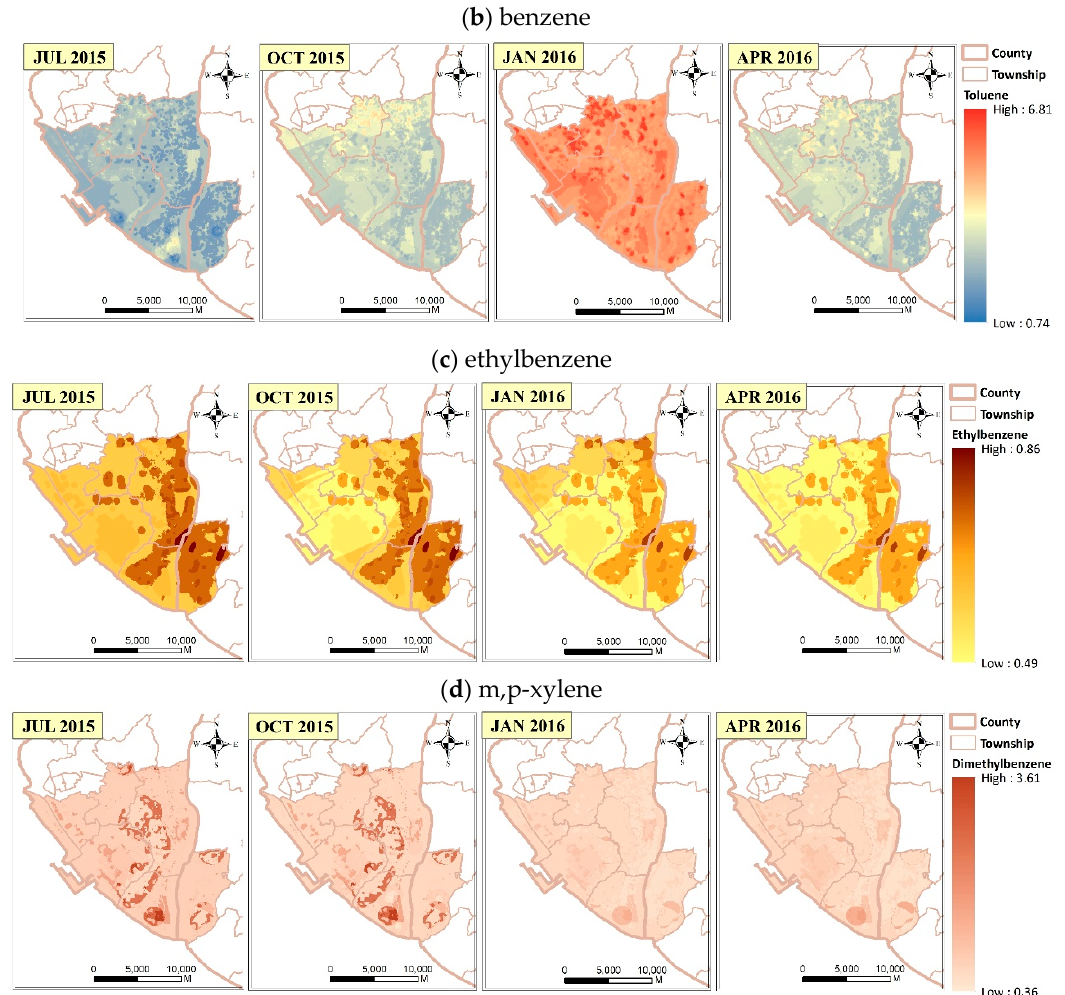
Figure 2. Monthly average concentration of BTEX: ( a ) benzene, ( b ) toluene, ( c ) ethylbenzene, and ( d )